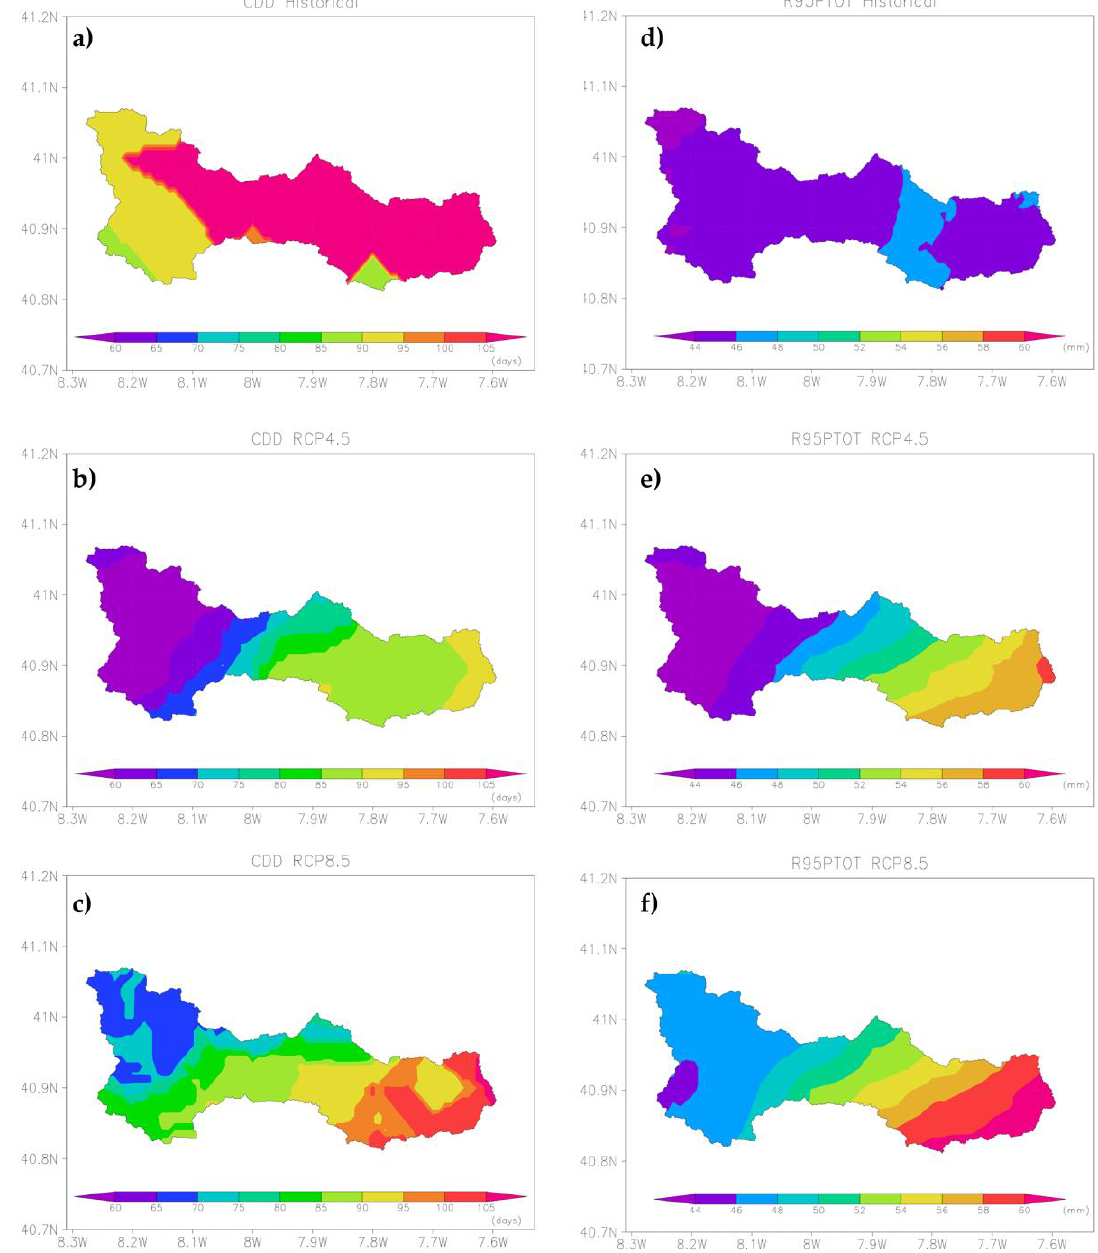
Figure 5. CDD—consecutive dry days and R95PTOT—Precipitation fraction in the Paiva catchment for ( a , d ) the historical period; ( b , e ) RCP4.5 and ( c , f ) RCP8.5.